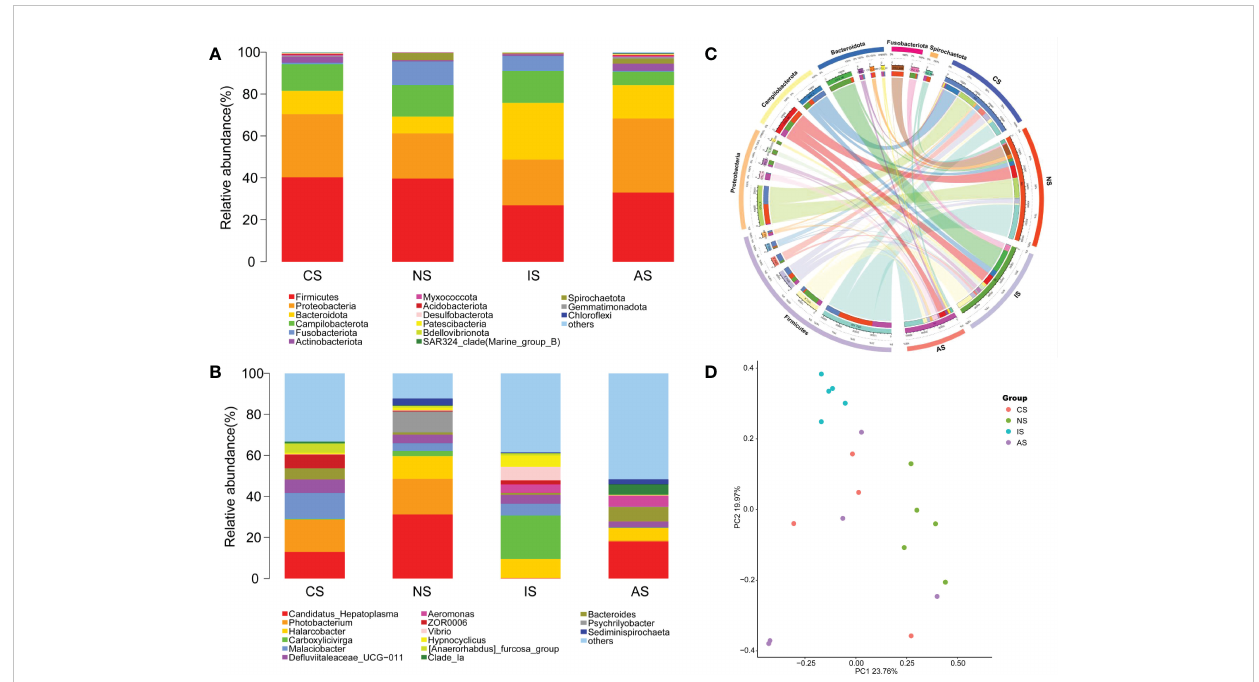
FIGURE 2 Composition and abundance of the intestinal microbiota. (A) Compositions and abundances of the gut microbiome communities at the top15 phylum level; (B) Compositions and abundances of the microbiome communities at the top 15 genus level; (C) Circos plot of the proportion of gut microbiome in the four groups at phylum level; (D) Principal coordinates analysis (PCoA) of the bacterial communities based on the Bray-Curtis